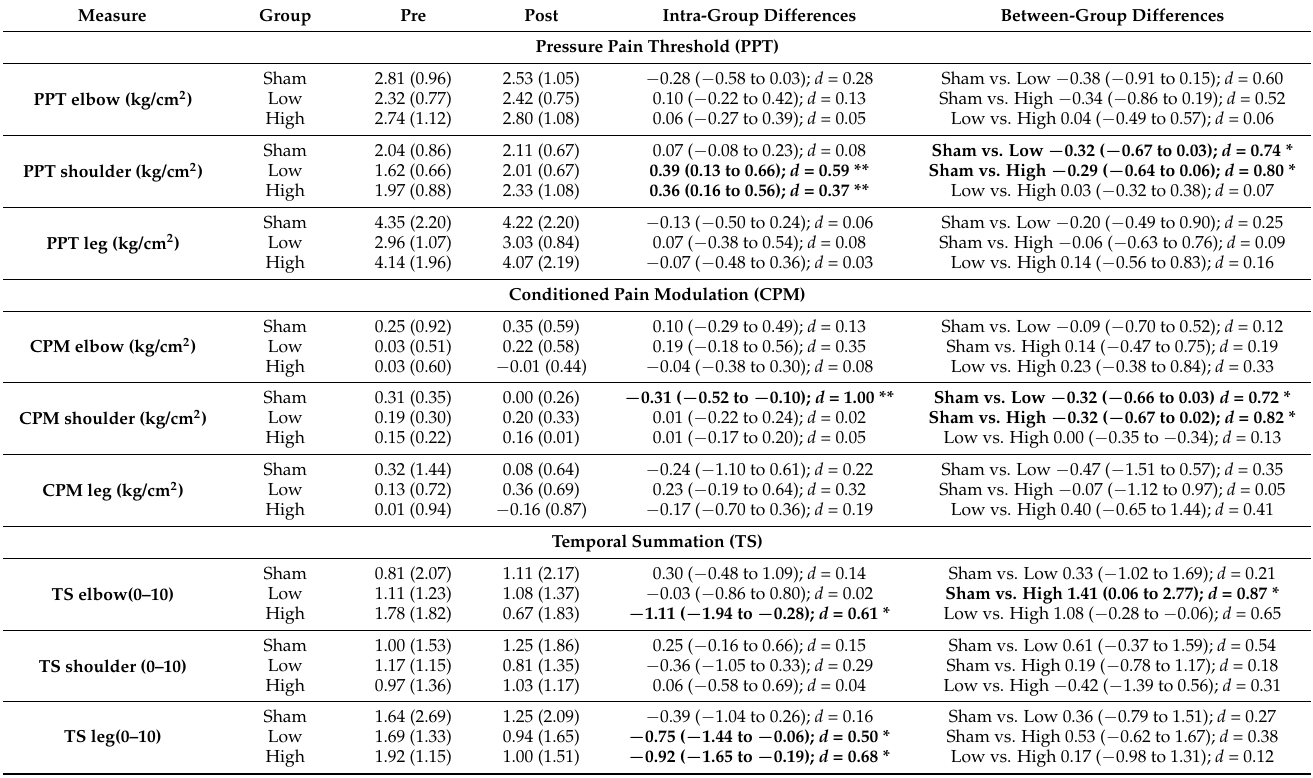
Table 2. Intra- and between-groups differences in outcome